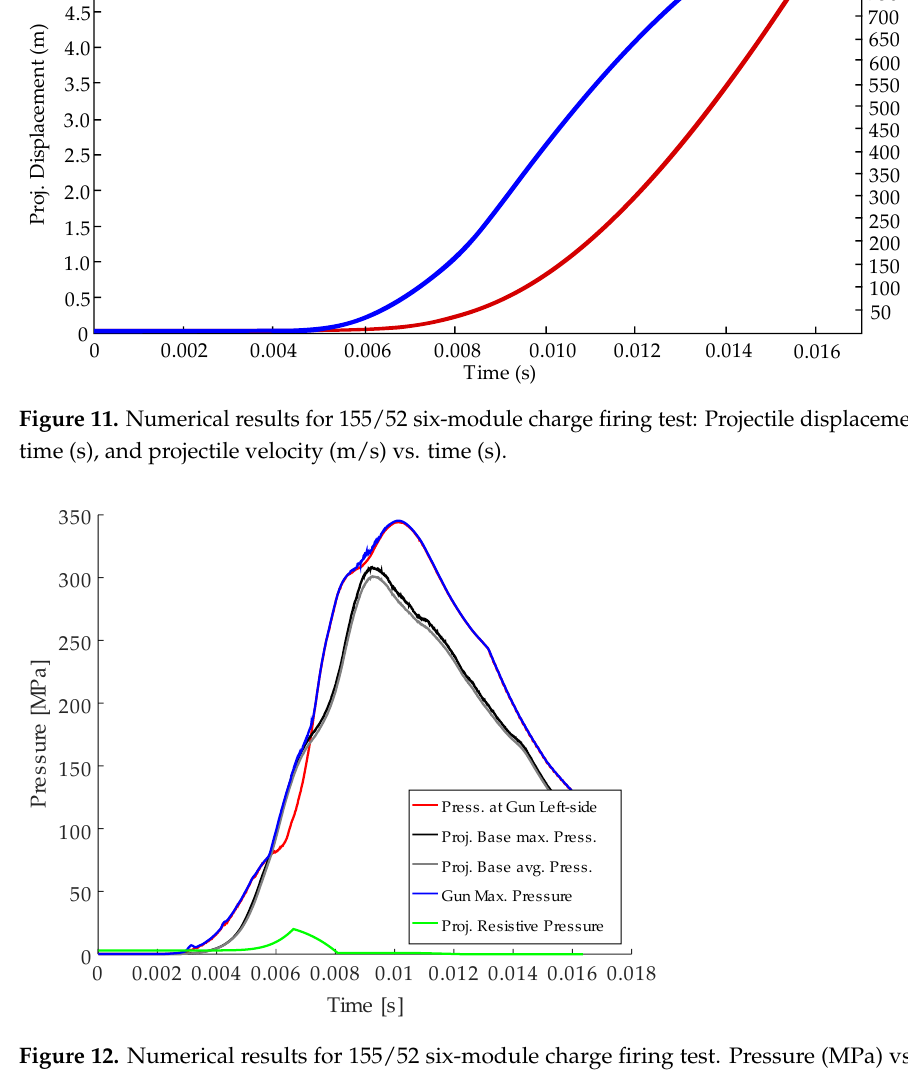
Figure 12. Numerical results for 155/52 six-module charge firing test. Pressure (MPa) vs. time (s) curve at different locations.